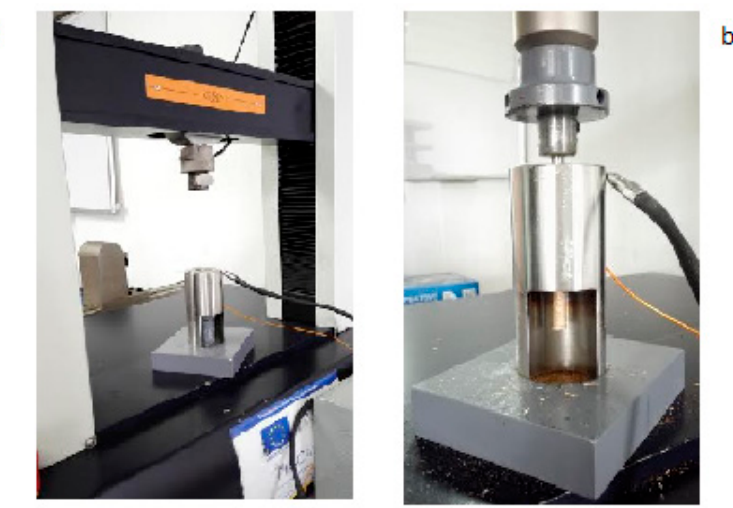
Figure 5. Universal test machine ( a ) and the pellet device built for pellet manufacturing ( b ).